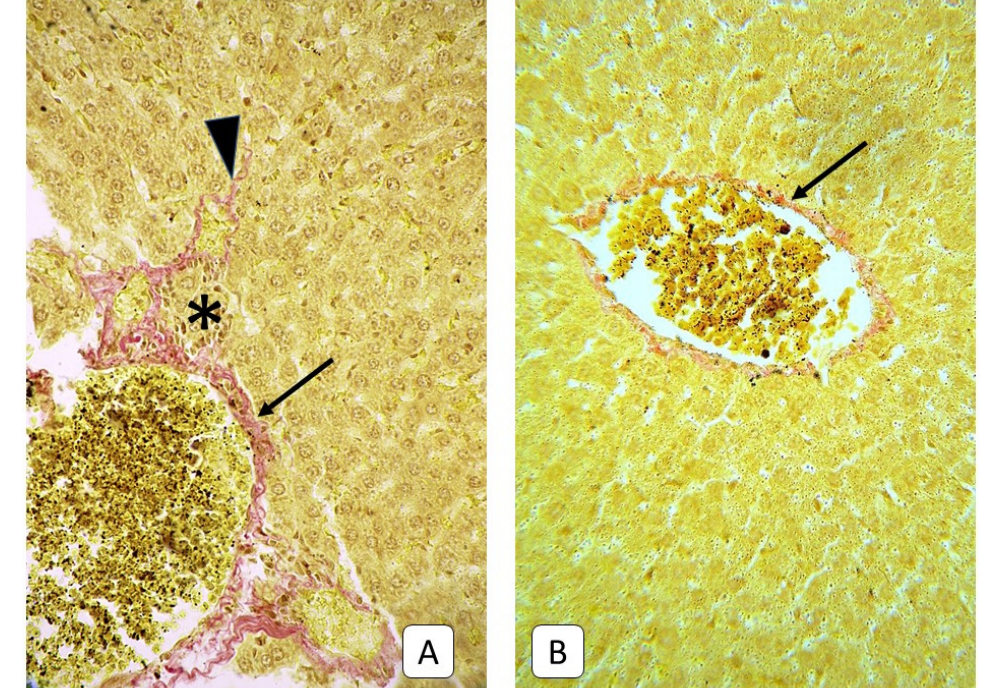
Figure 10. Photomicrograph of the liver. ( A ): adult rats, 21st day after mTBI. Periportal infiltrate (asterisk) with collagen fibers (arrow) and collagen invasion deeper to parenchyma (arrowhead). ( B ): control group. Collagen fibers in the wall of central vein (arrow). VanGiesone, × 400.